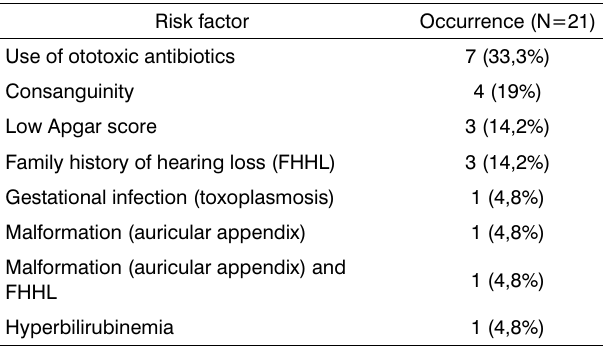
Table 1. Hearing loss risk factor